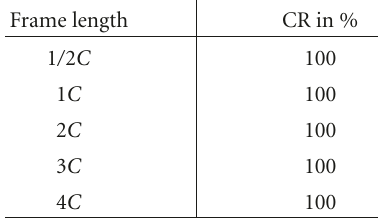
Table 2: Performance of the proposed technique for harmonic clas- sification.